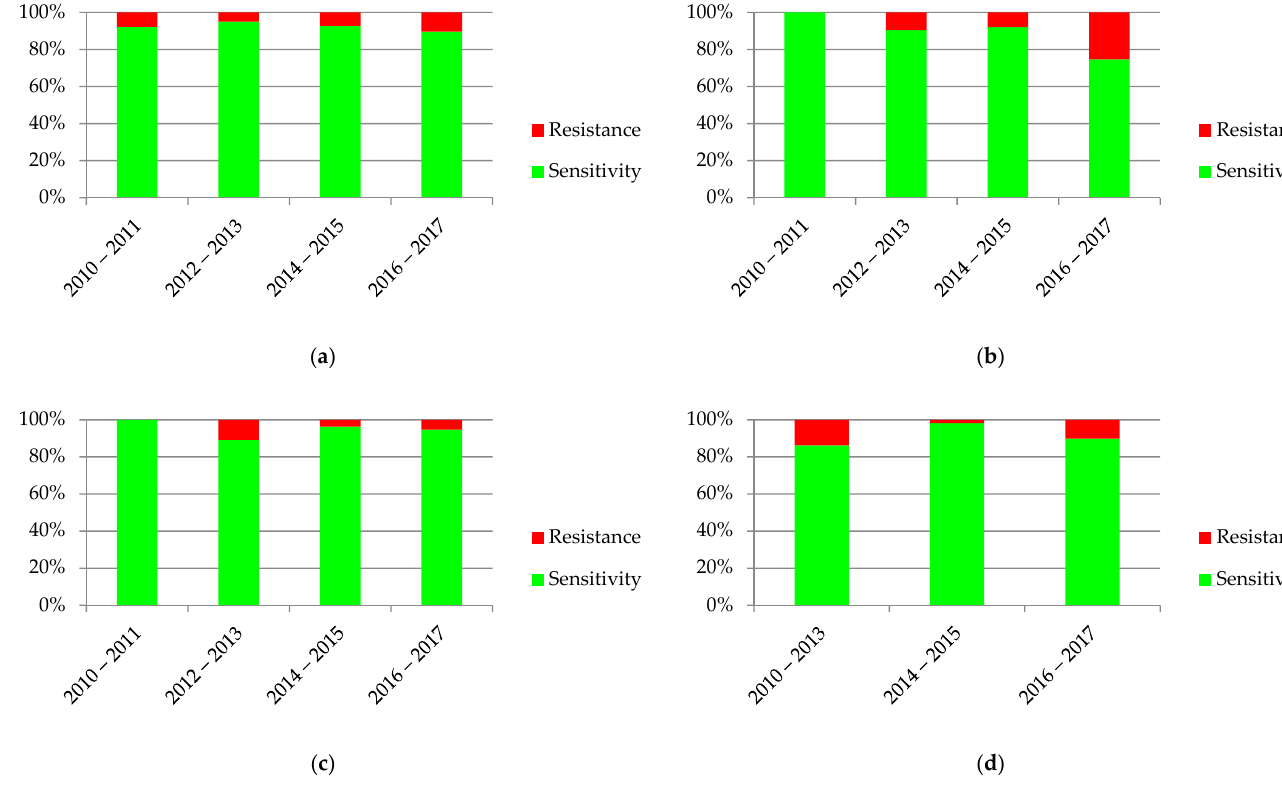
Figure 6. Sensitivity and resistance of bacteria to antibiotics from 2010–2017.